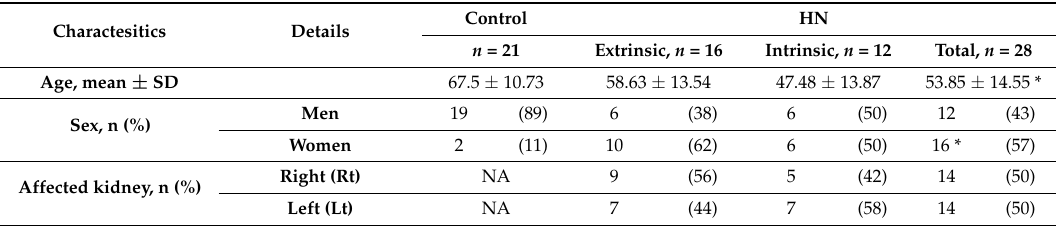
Table 1. Characteristics of